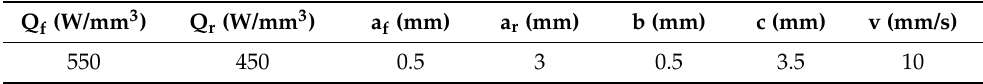
Table 1. Goldak’s heat source parameters (see Figure